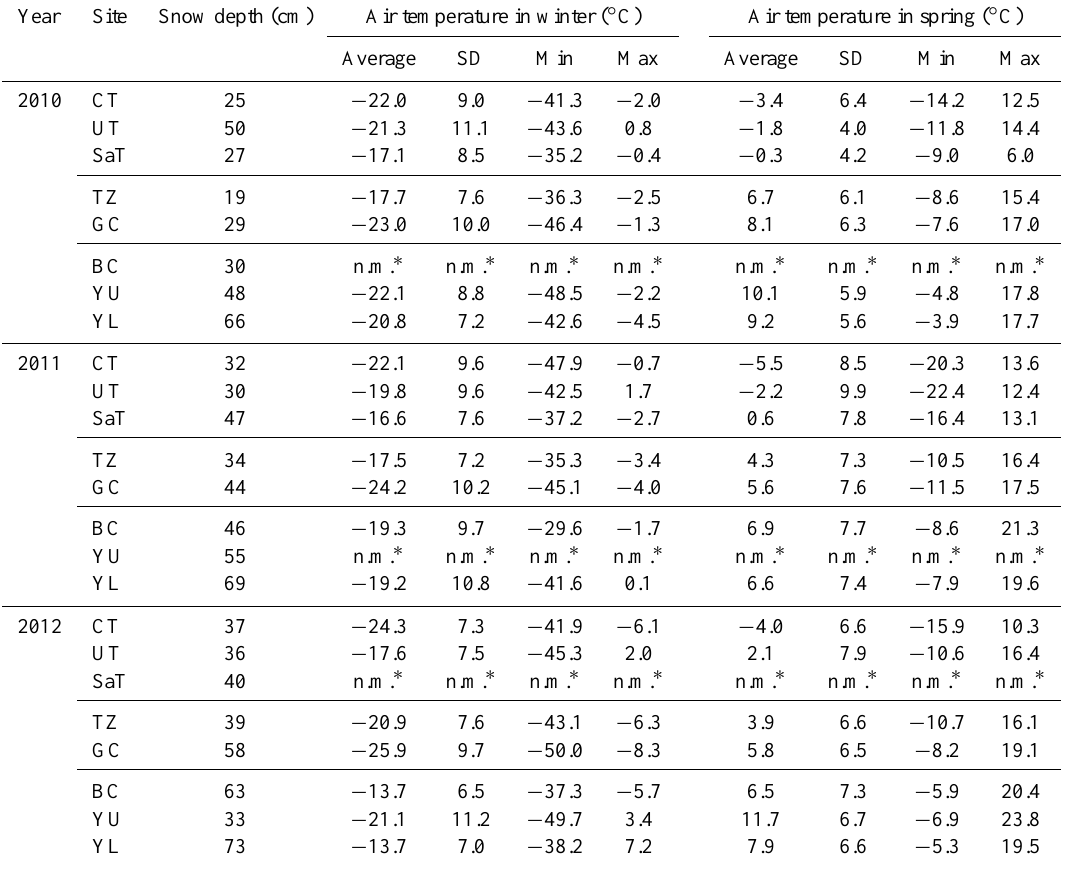
Table 2. Snow depth during the spring season of 14 April–14 June and air temperatures during the winter seasons of November–March of 2011 and